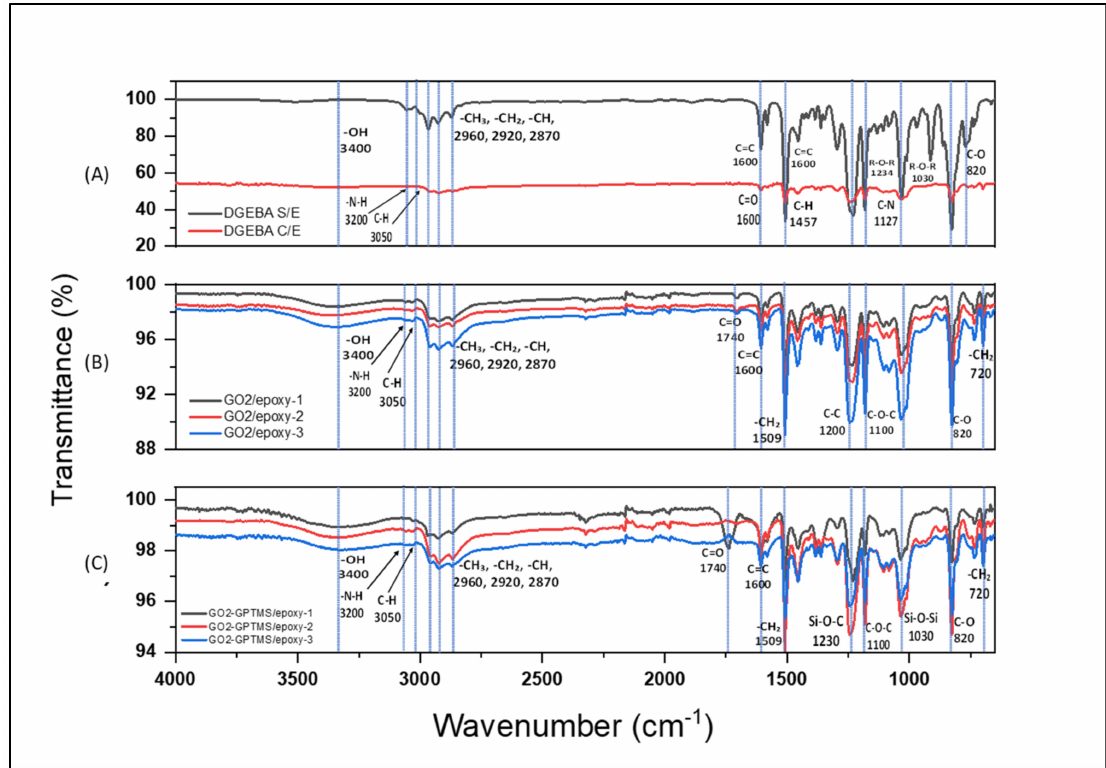
Figure 5. FTIR spectrum ( A ) DGEBA S/E and DGEBA C/E epoxy resin, ( B ) GO2/epoxy nanocom- pounds, and ( C ) GO2-GPTMS/epoxy nanocompounds.